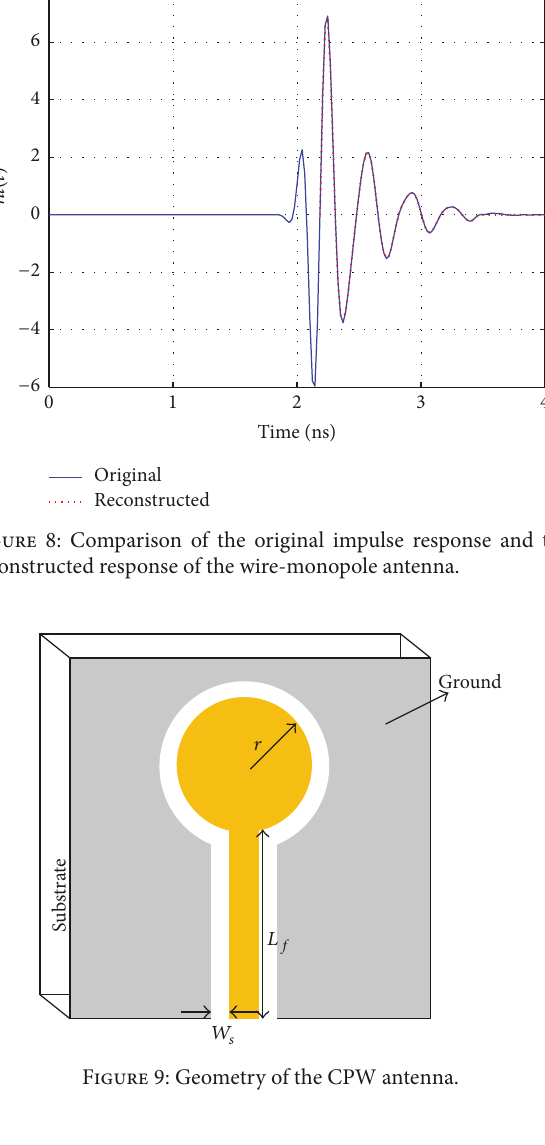
response of the antenna are shown in Figures 10 and 11, respectively.